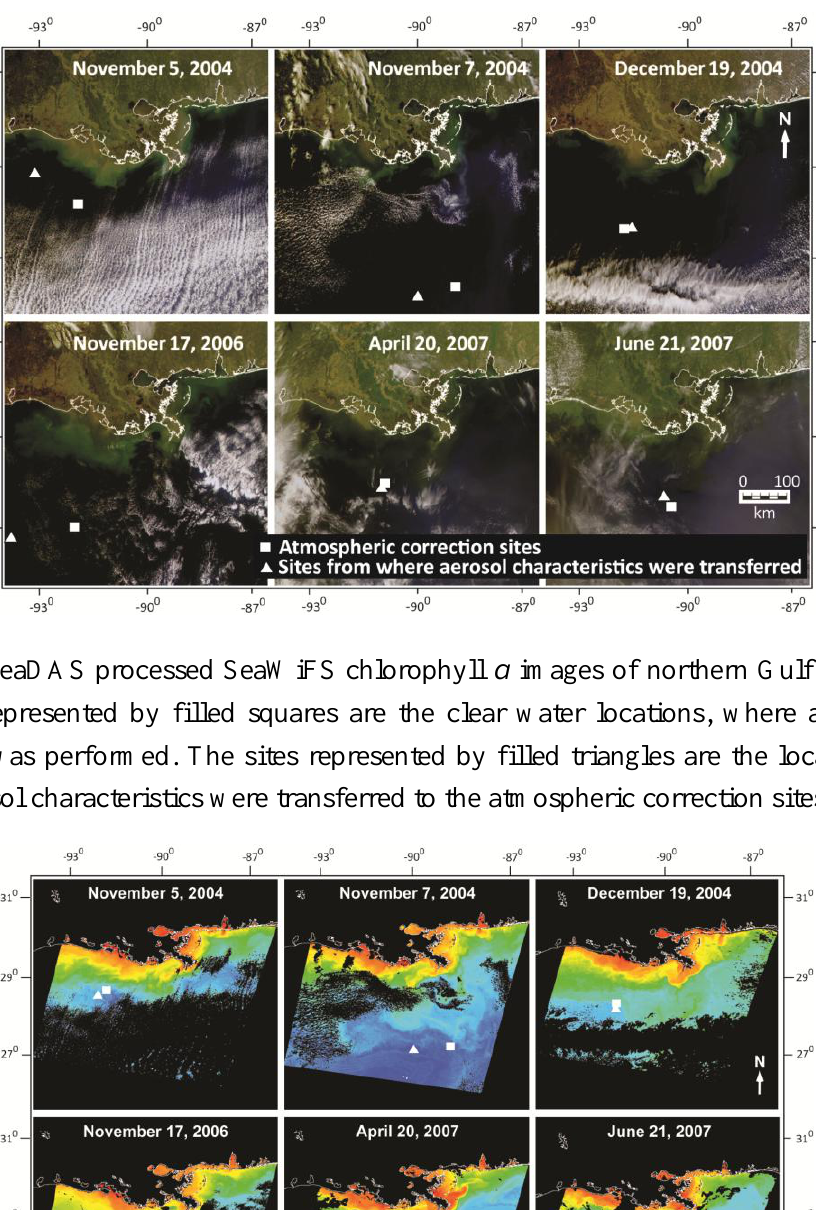
Figure 1. OCM true color images of northern Gulf of Mexico. The sites represented by filled squares are the clear water locations, where atmospheric correction was performed. The sites represented by filled triangles are the locations from where aerosol characteristics were transferred to the atmospheric correction sites.